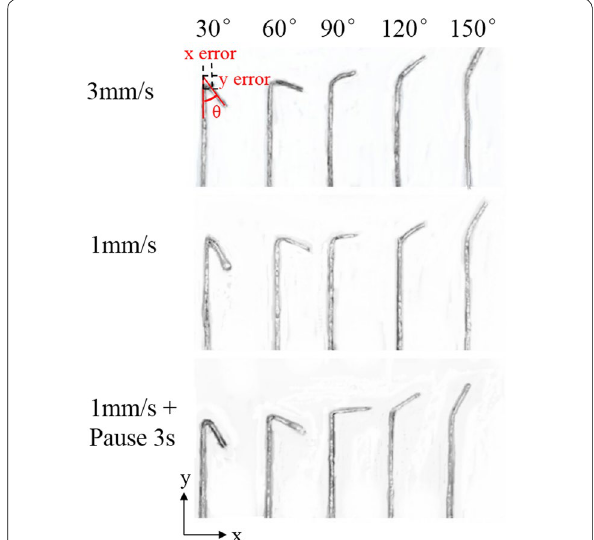
Figure 7 Monofilaments with different